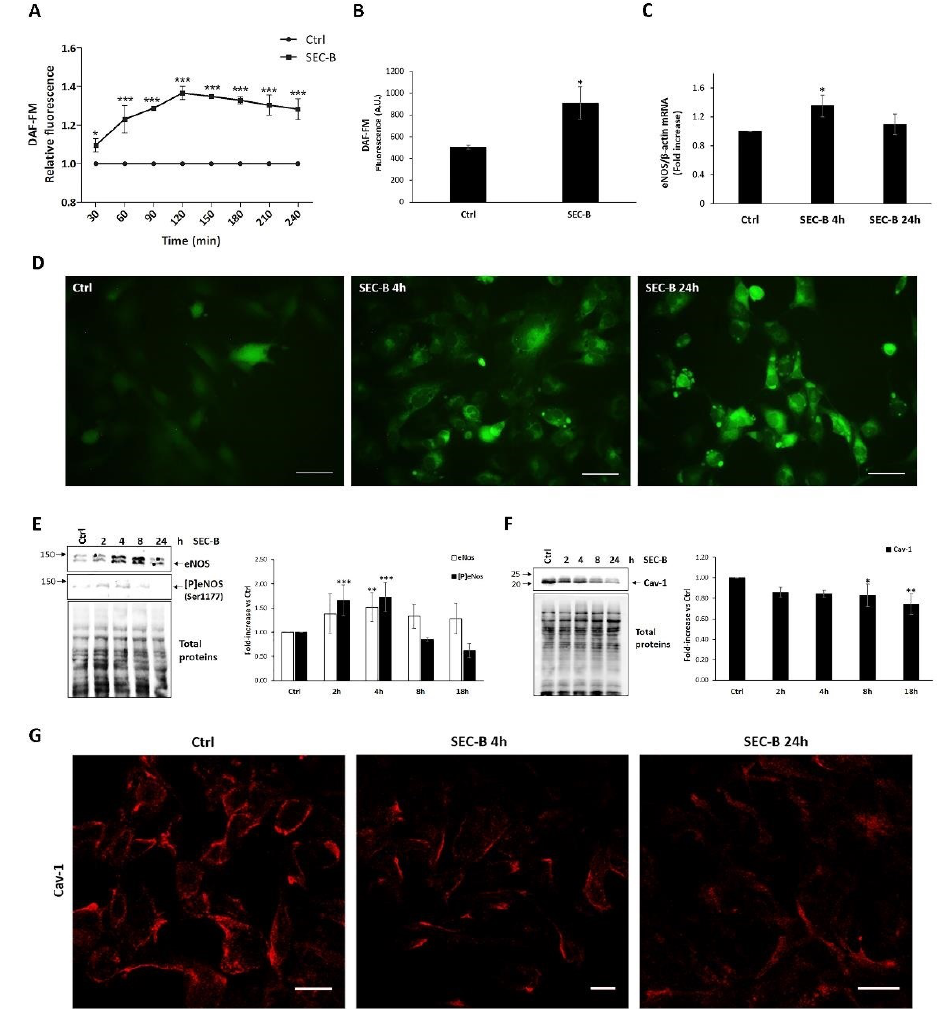
Figure 3. SEC-B induces NO accumulation and eNOS/Cav-1 modulation in HMEC-1 cells. ( A ) Intracellular NO increases during the first 4 h of SEC-B treatment. Data are expressed as a fold increase of DAF-FM fluorescence emission compared to control conditions. ( B ) Intracellular NO level after 24 h of SEC-B treatment. The DAF-FM fluorescence is reported as arbitrary units (A.U.). The means ± SD ( n = 3) are indicated. ( C ) Real-time PCR of eNOS mRNA expression at 4 h and 24 h post-treatment. Data are normalized with β -actin. ( D ) Representative microscopy images of HMEC-1 labeled with DAF-FM probe after 4 h and 24 h of SEC-B treatment. The images are obtained by optical fluorescence microscopy using the 40× objective. Scale bar: 50 µm. ( E,F ) Western-immunoblotting analysis of eNOS, [P]eNOS (Ser1177) and Cav-1 levels in whole cell extracts. Then 20 μg of proteins were loaded onto 8% ( w / v ) SDS polyacrylamide gels for eNOS and [P]eNOS detection, while 5 μg of proteins were loaded onto 12% ( w / v ) SDS polyacrylamide gels for Cav-1 analysis. After blotting, total protein was stained on the membrane using the no-stain reagent as described in Materials and Methods, and then protein targets were detected using specific antibodies. The position of molecular weight markers (kDa) is shown on the left. Images were acquired in a ChemiDoc system, and signal intensity relative to immunoreactive bands and total protein content were quantified with Image Lab software. Values were normalized on total proteins and expressed as fold-increase vs. the value obtained in untreated cells set as 1. Bars represent the mean ± SD ( n = 3). ( G ) Confocal images of Cav-1 immunostaining in HMEC-1-treated cells after 4 h and 24 h of SEC-B administration. Scale bar: 20 µm. Data are expressed as mean ± SD ( n = 3). * p < 0.05; ** p < 0.01; *** p < 0.001 vs. untreated cells.